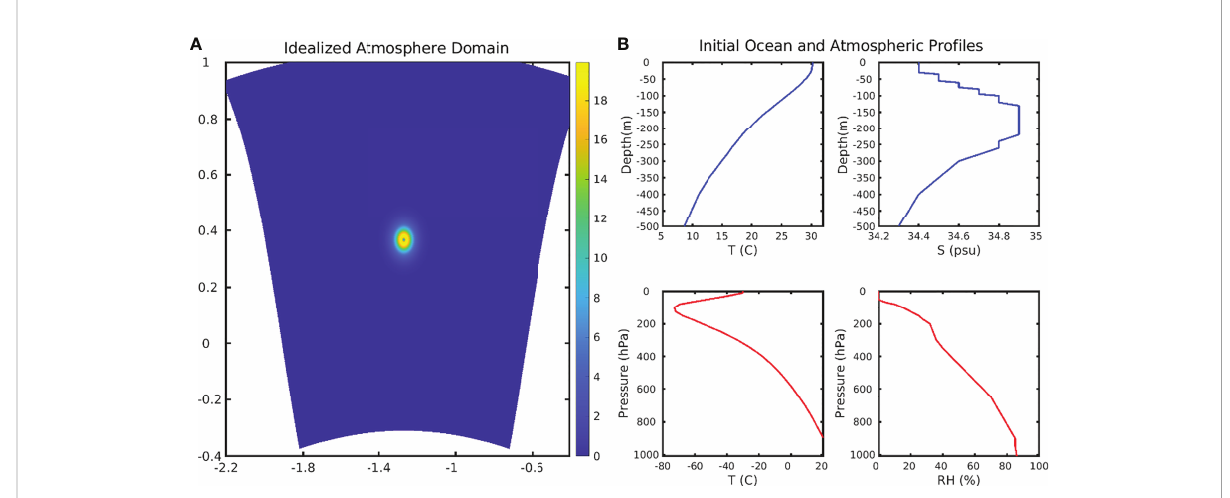
FIGURE 4 (A) Model domain for idealized experiments. Colors show wind speed with the initial vortex situated at the center of the domain. (B) Initial oceanic and atmospheric pro fi les used in idealized experiments. All initial temperature and salinity pro fi les for the ocean and initial temperature and humidity sounding are horizontally